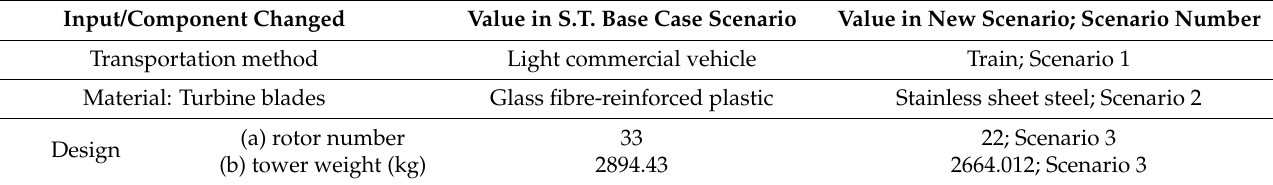
Table 5. Changes to CML inputs for Scenarios 1 to